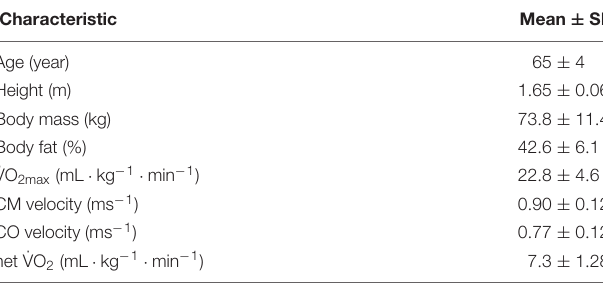
TABLE 1 | Participant characteristics at baseline ( n =